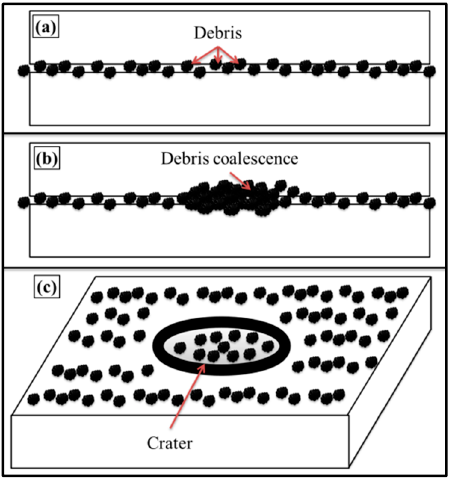
Figure 19. Indenter pressed against: ( a ) smooth; ( b ) rough surfaces.